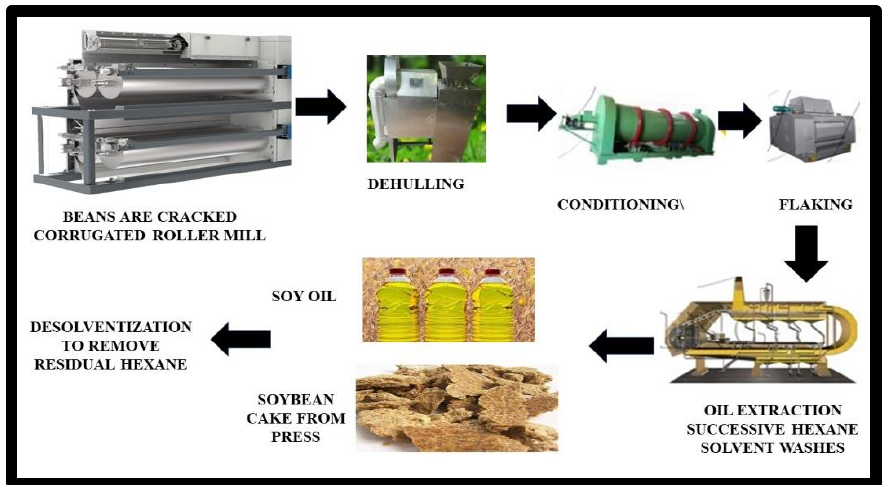
Figure 2. Post-Harvest Soybean Processing. Post-harvest raw soybeans are cracked using corrugated rollers, and are subsequently dehulled, conditioned, and flaked prior to oil extraction. Soy oil is extracted from the conditioned flakes via successive hexane solvent washes. Residual hexane is removed from soybean cake to produce edible solvent extracted defatted soybean meal and soy oil.